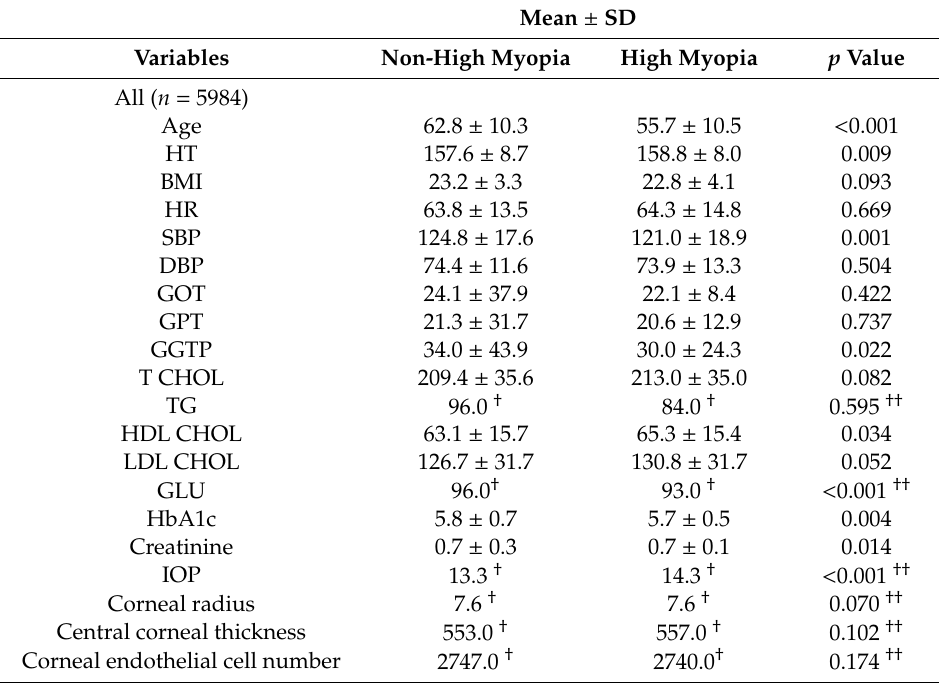
Table 1. The association between systemic and ocular features and high myopia.